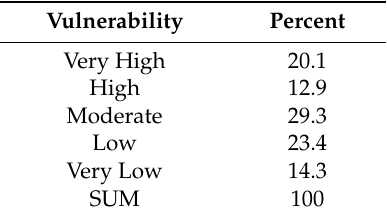
The level of residential buildings vulnerability in Tabriz city according to their geotechnical